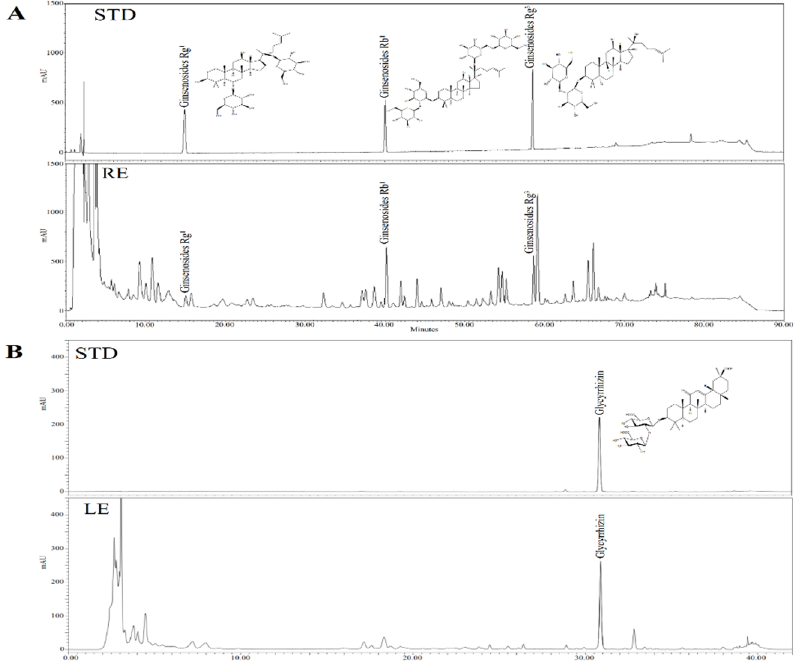
Figure 1. HPLC chromatograms of major compounds of ( A ) RE and ( B ) LE. RE—red ginseng extract; LE—licorice extract; STD—standard compounds. Identification of major compounds was determined by comparing to retention times of the STD.